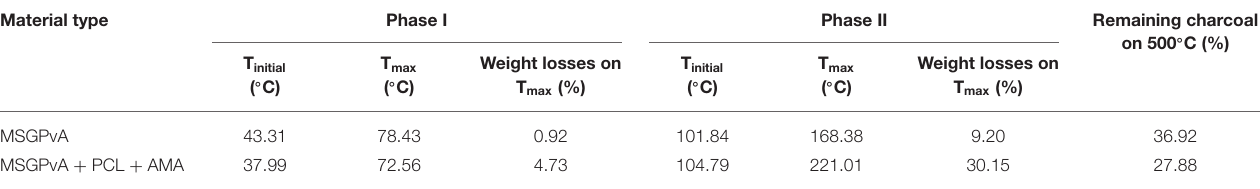
TABLE 2 | Initial temperature, maximum temperature, and weight loss in the evaporation process (phase I) and degradation (phase II) of MSGPvA BtC with and without PCL and